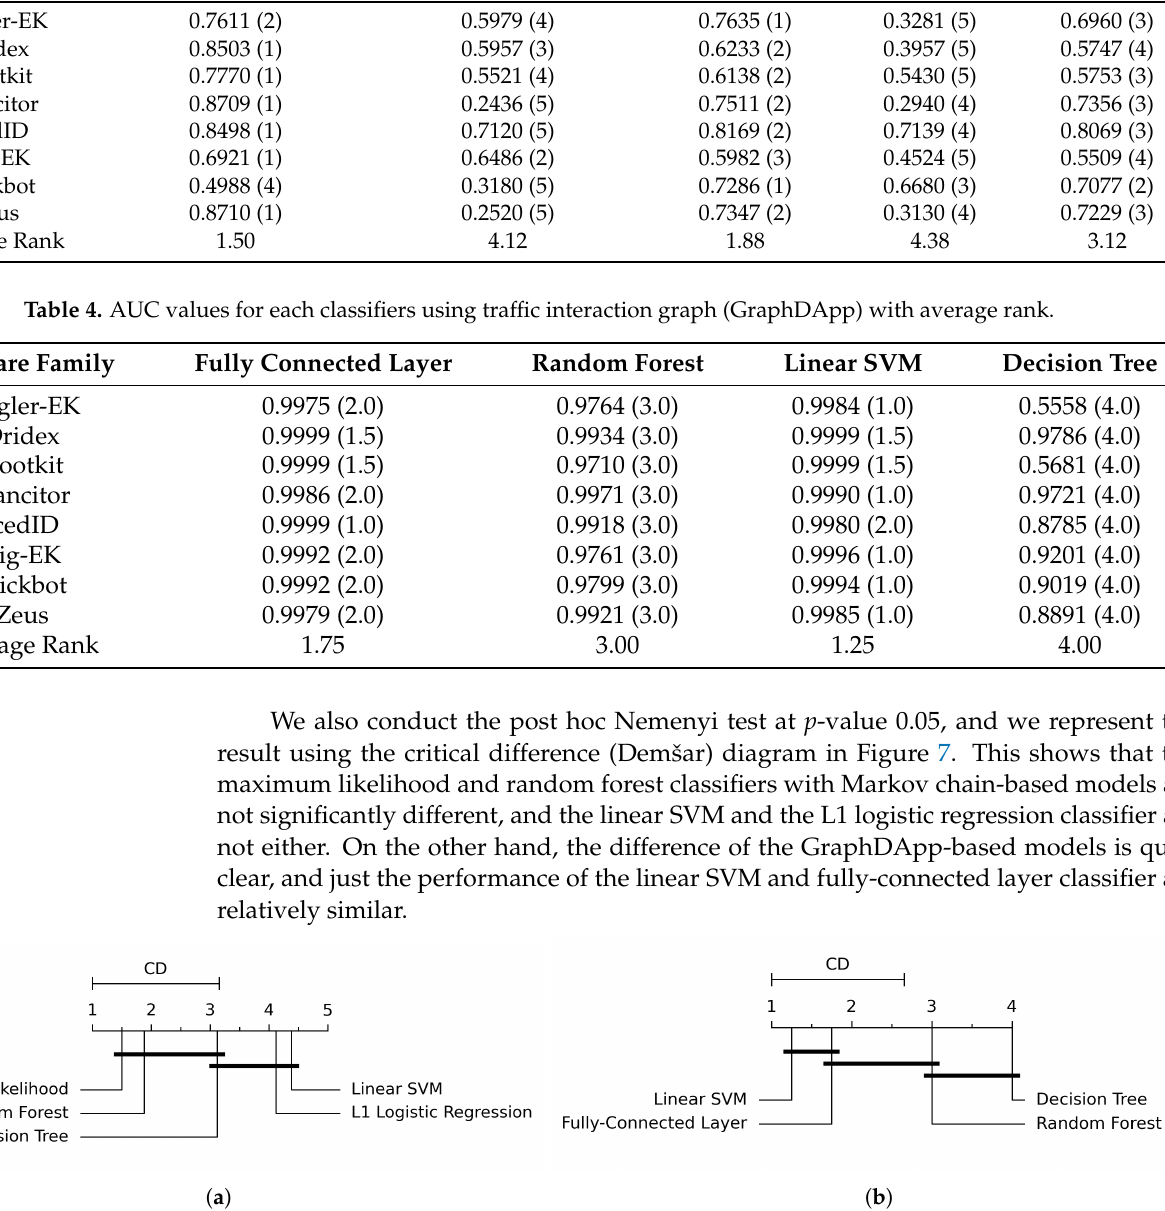
Figure 7. The critical difference diagram of the post hoc Nemenyi test for ( a ) Markov chain fingerprinting and ( b ) traffic interaction graph